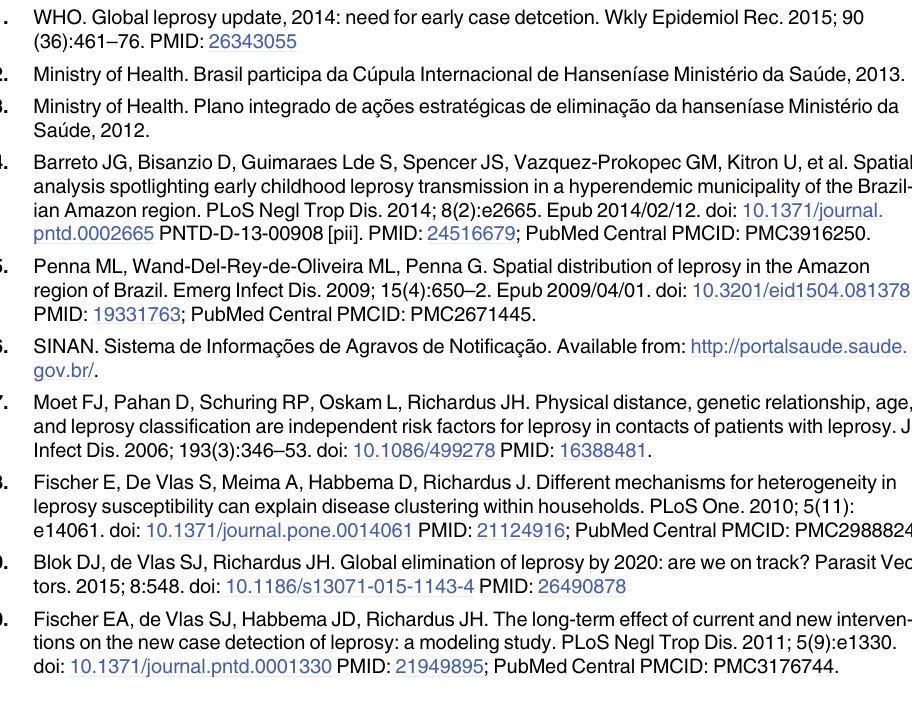
S1 Fig. Impact of chemoprophylaxis on the new case detection rates of leprosy assuming a lower coverage of contact tracing